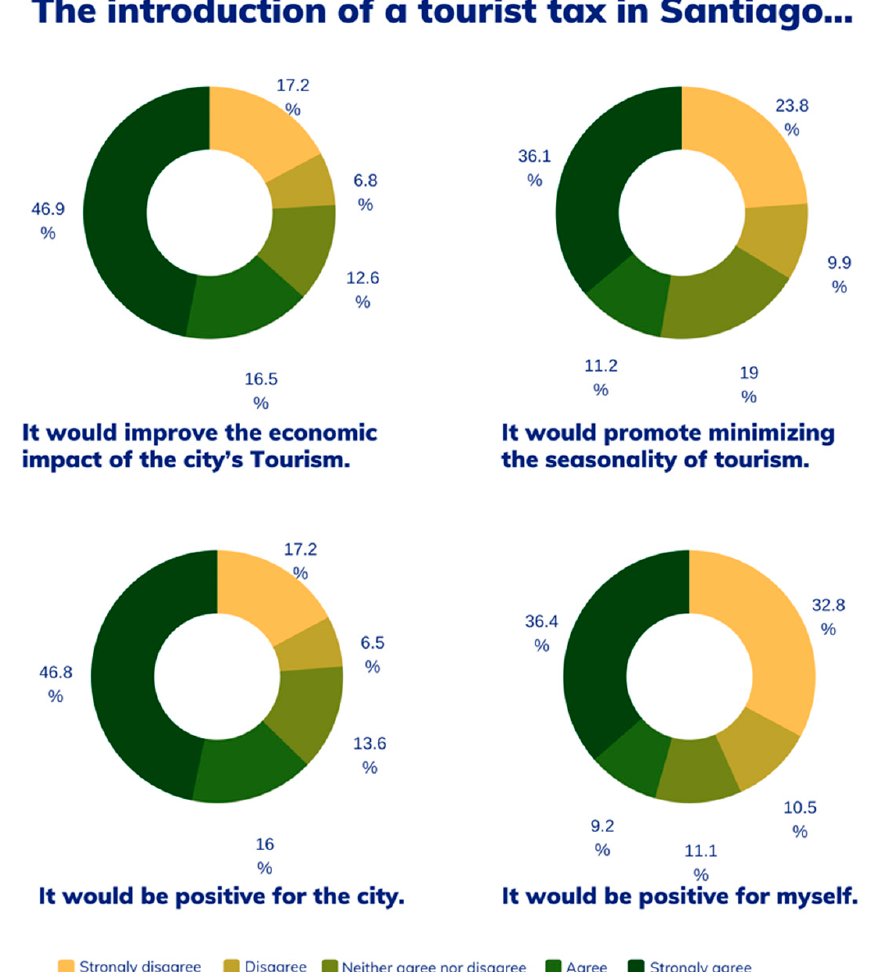
Figure 3. Answers to the questionnaire (percentages related to a 5-point Likert scale) reflecting the local communities’ perceptions about the introduction of a tax in Santiago. Source: own elaboration.